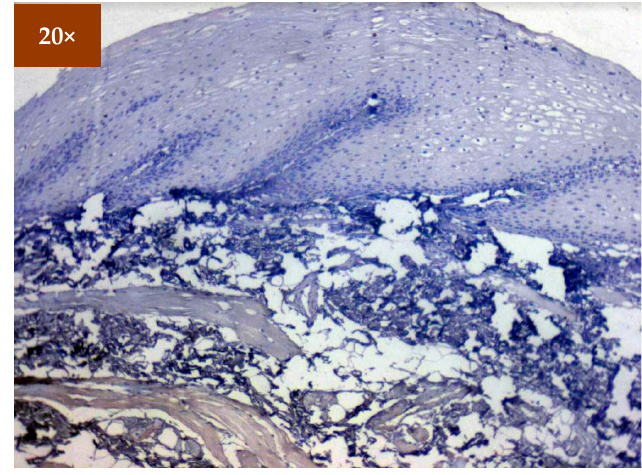
Figure 3. IHC for EGFR in healthy controls (under 20× magnification).